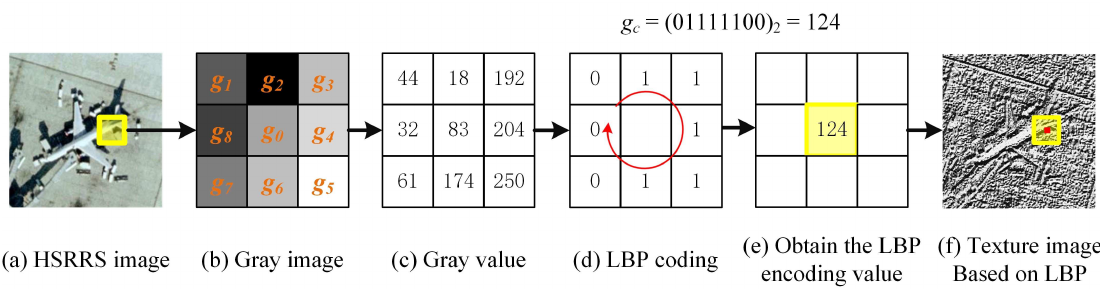
Figure 2. The principle of local binary pattern (LBP) descriptors. HSRRS—high spatial resolution remote